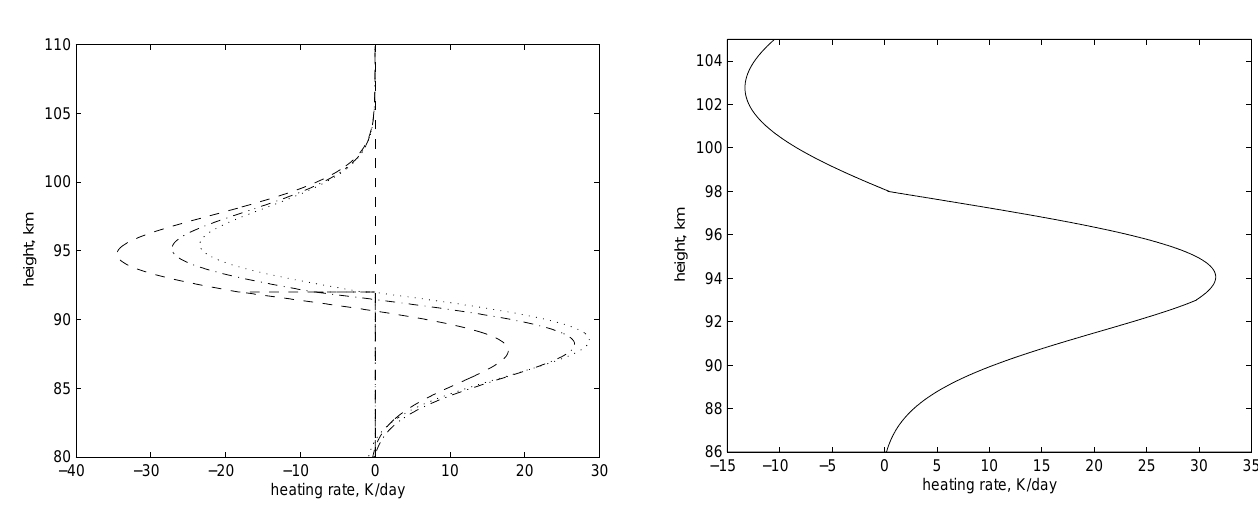
Fig. 4. Heating rate profile corresponding to the double mesopause shown in Fig. 1 and calculated with Ri =0.5 and P =1.